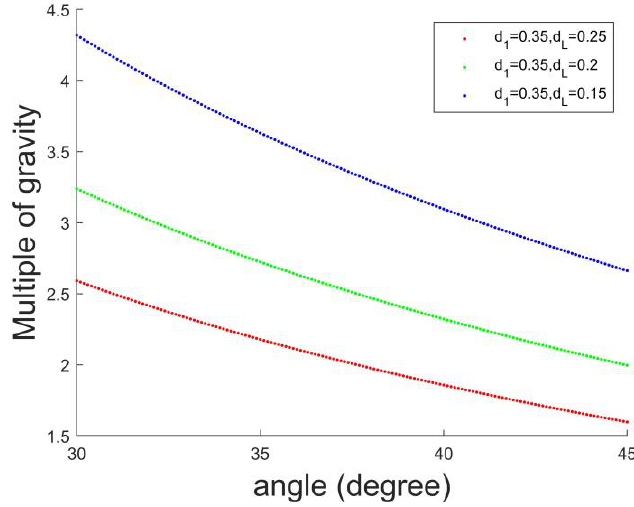
Figure 9. Influence of the support bar angles θ s to the support force N 2